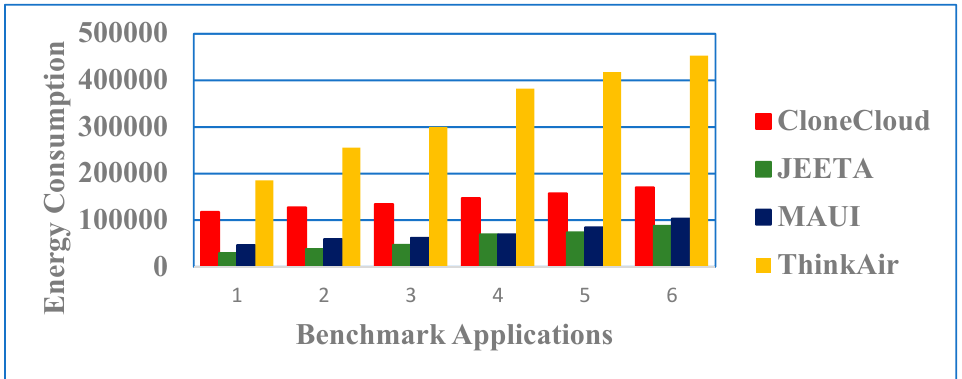
Figure 4. Application partitioning performance based on speed up factor F and bandwidth B.